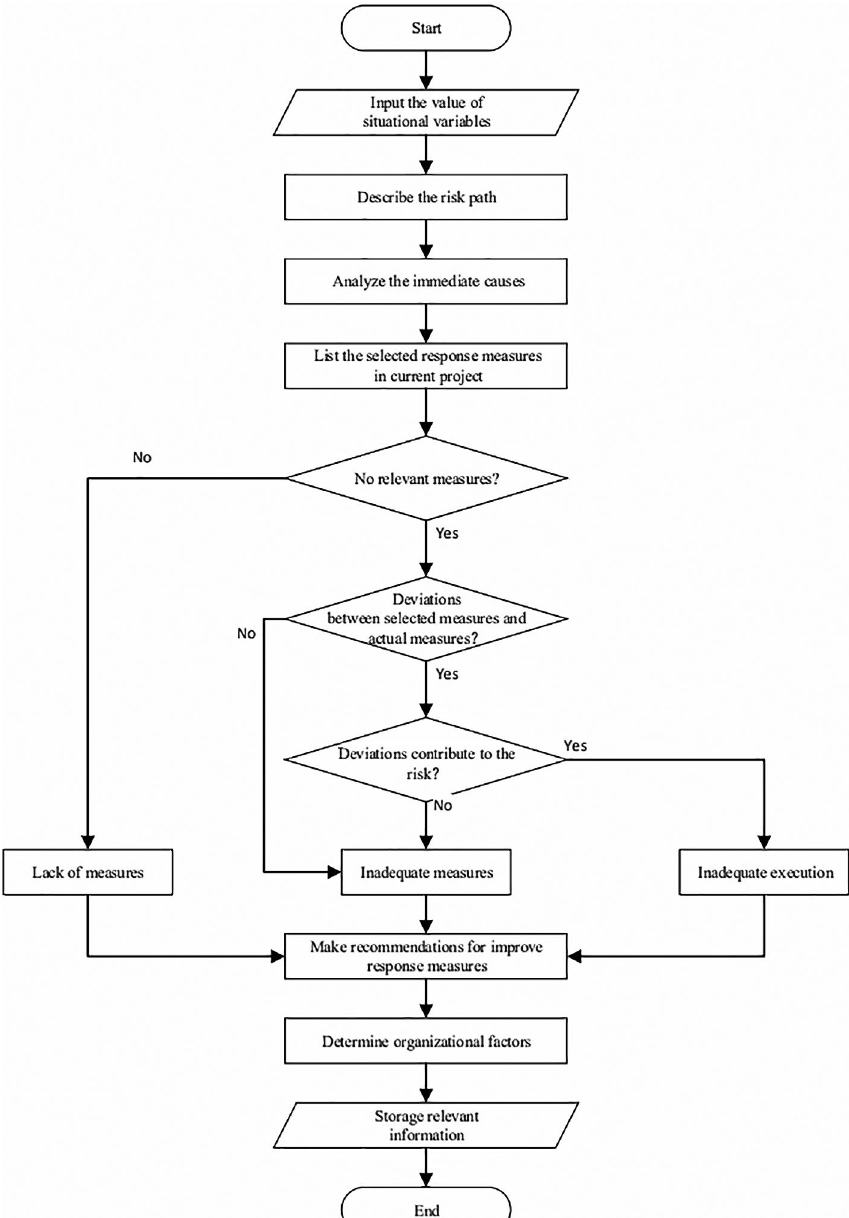
Figure 3. Formal procedures to review risks based on the